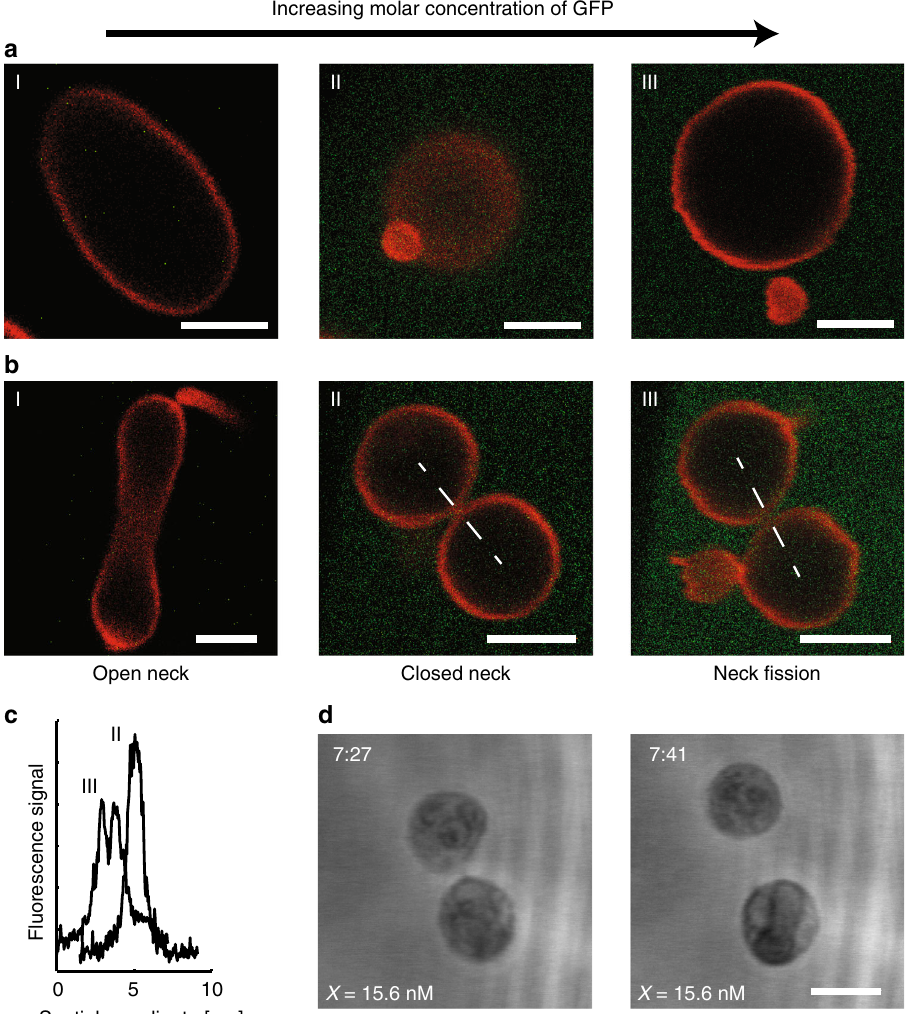
Fig. 3 Division of GUVs (red) by increasing the GFP concentration. a Asymmetric division of a single GUV into one large and one small daughter vesicle. b Symmetric division of a single GUV into two daughter vesicles of equal size. The division process starts, in the absence of GFP, from a certain vesicle shape as displayed in I. Addition of GFP then transforms each GUV into two spherical membrane segments that are connected by a closed membrane neck as in II. A further increase in the GFP concentration leads to the cleavage of the neck and to the division of the GUV as shown in III. The GUVs in ( a ,III) and ( b ,III) are denoted by D † and E † , respectively. The key parameter that controls the relative size of the two daughter vesicles is the volume-to-area ratio v (see the “ Methods ” section, Eq. (6)). c Pro fi le of lipid fl uorescence along the white dashed line in ( b ,II) indicates a closed neck but neck fi ssion along the white dashed line in ( b ,III). d Two snapshots from Supplementary Movie 2: The GUV had the dumbbell shape F † when it underwent neck fi ssion after about 7:27 min:s, resulting in two daughter vesicles that diffused freely away from each other and were completely separated at 7:41 min:s. The parameters for the shapes D † , E † , and F † are included in Table 1. The membranes in a and b contained 0.1 mol%, the one in d 1 mol% anchor-lipids. All scale bars: 5 μ m. Source data for panel c are provided in the Source Data fi